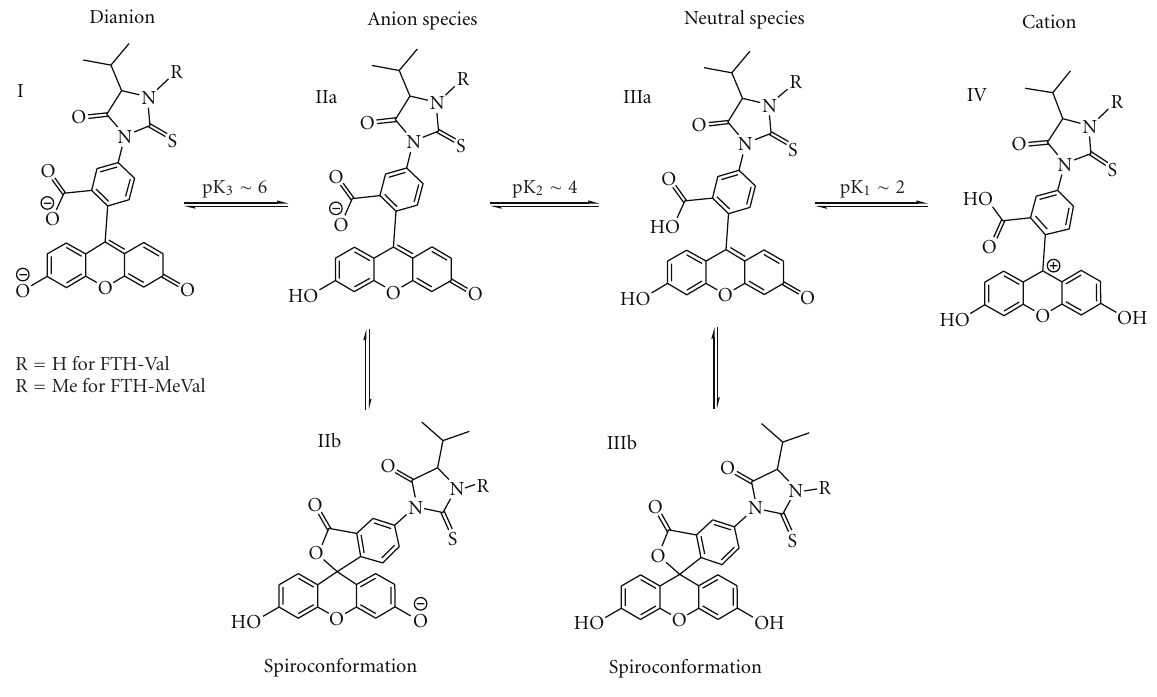
Figure 3: Chemical forms the FTH-analytes in aqueous solution ∗